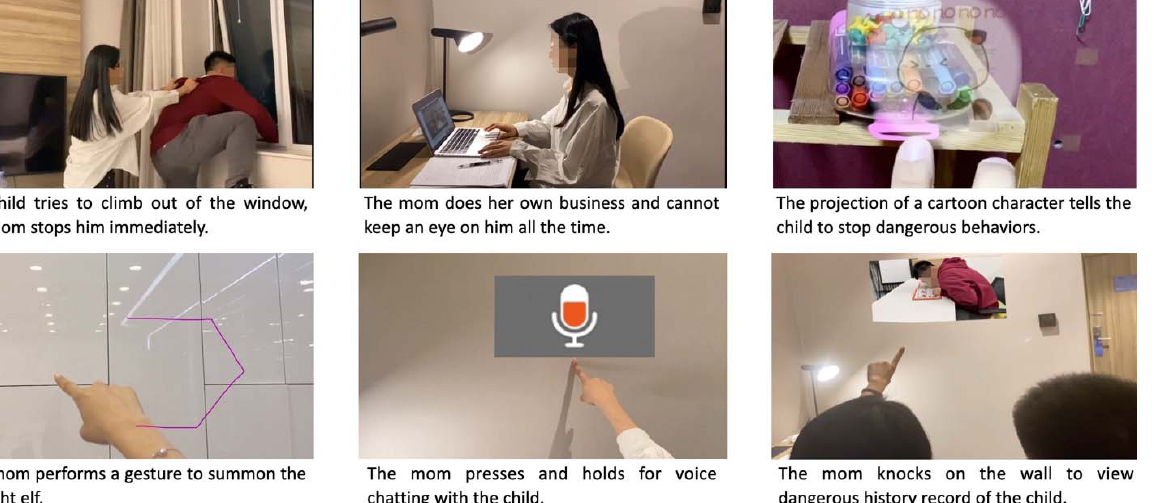
Figure 5. The HCI logic diagram.